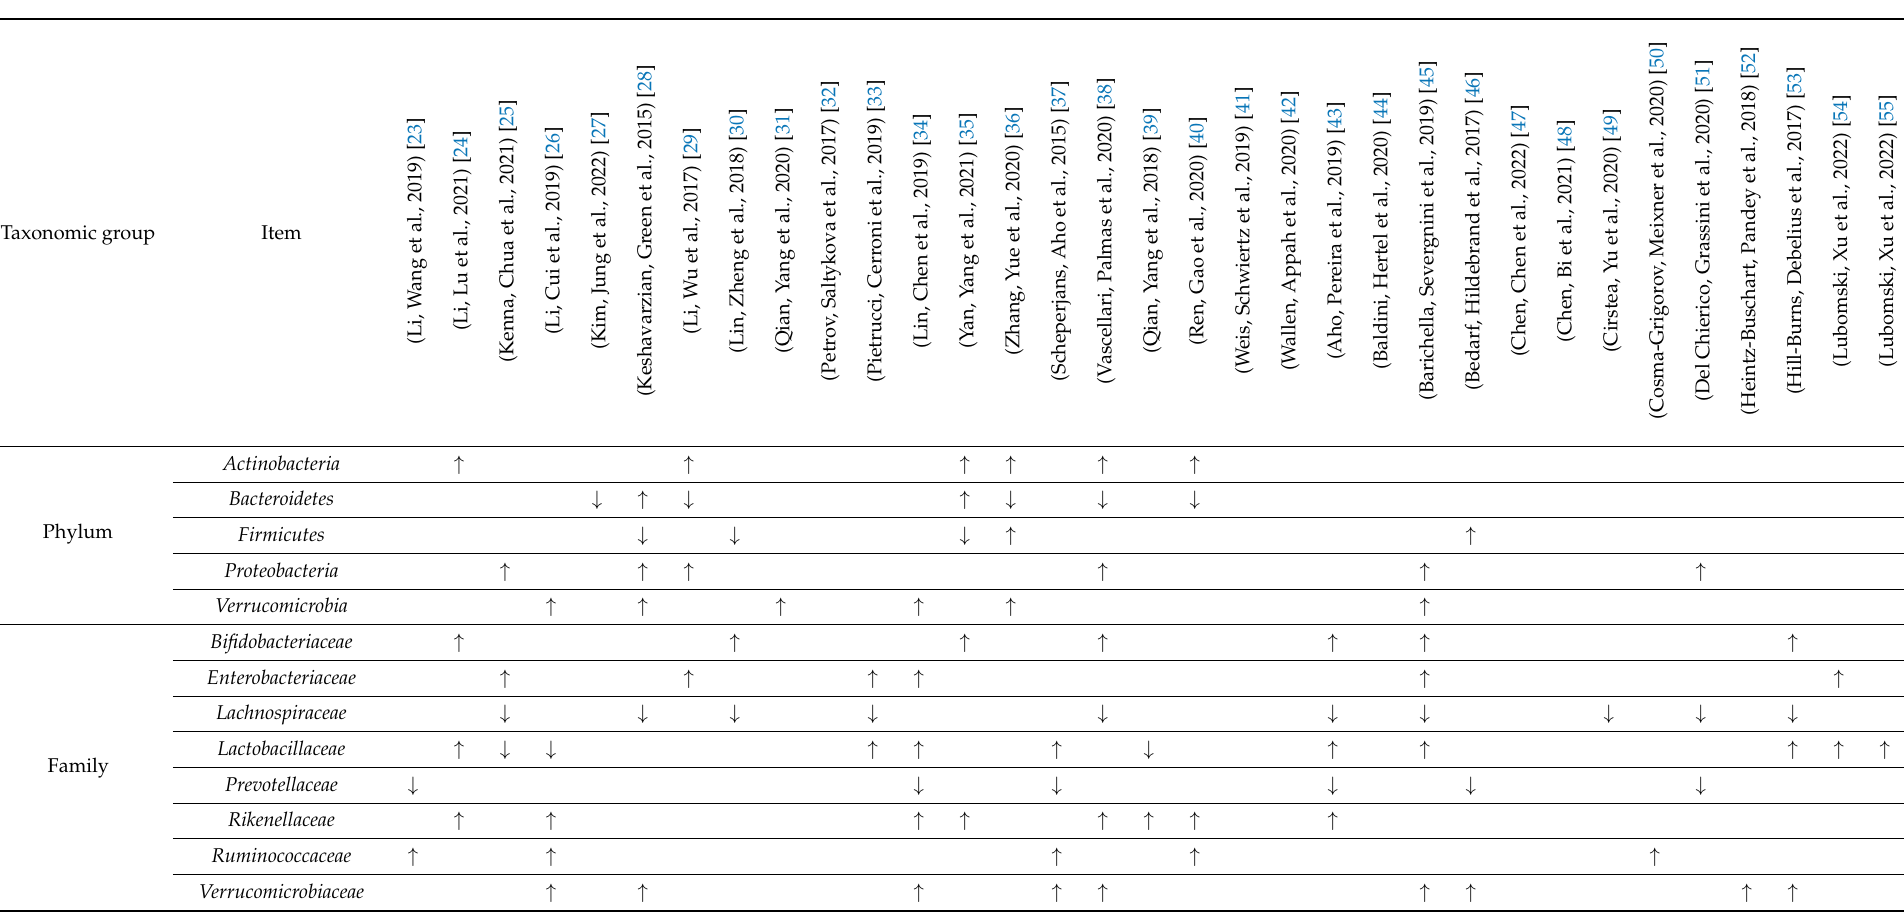
Table 1. Parkinson disease patients and healthy controls: research papers and their conclusions—summarized version ([ ↑ / ↓ ]-increase/decrease of abundance in comparison patients with Parkinson’s Disease to Healthy Control, PD—patients with Parkinson’s Disease, HC—healthy controls).